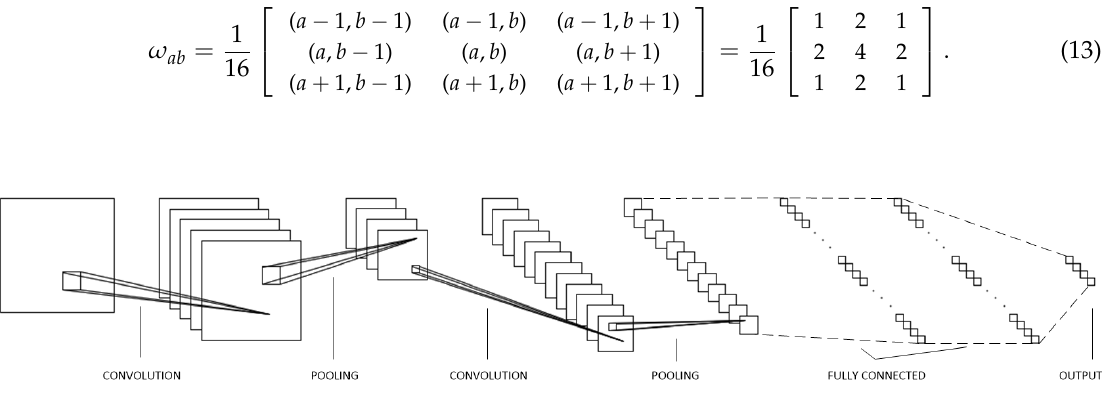
Figure 8. Sample scheme of the Convolutional Neural Network composed to process clustered images of suspicious skin